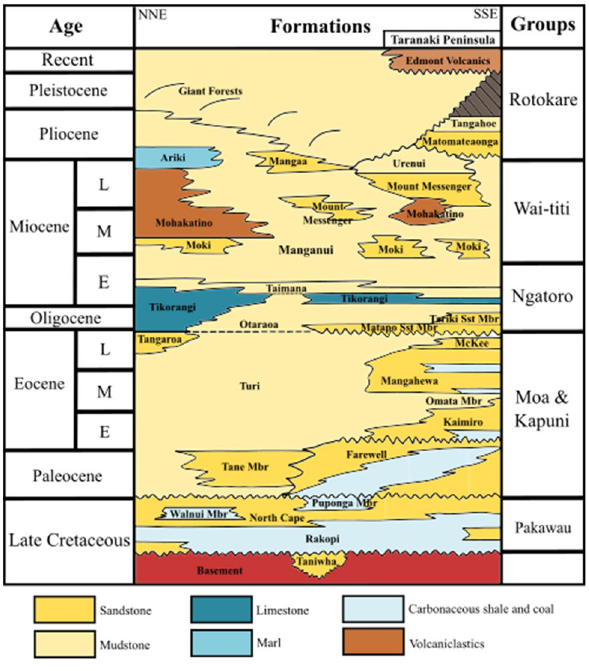
Fig. 2 The generalized stratigraphy of the Taranaki Basin, modified after Jumat et al.